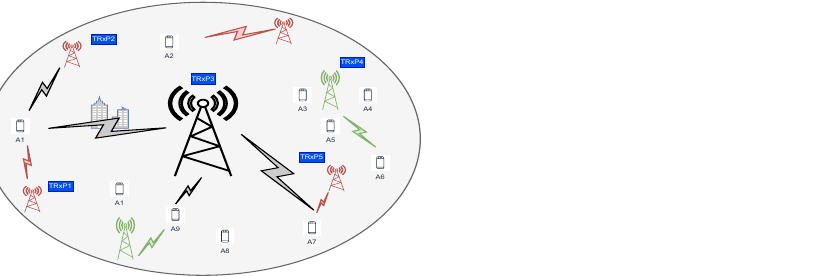
Figure 3. Users moving through the network have single or multiple selection options to perform a RA request depending on their